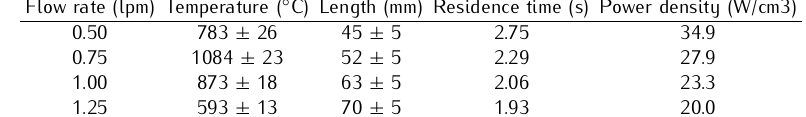
Table 2. Microwave Plasma Characteristics